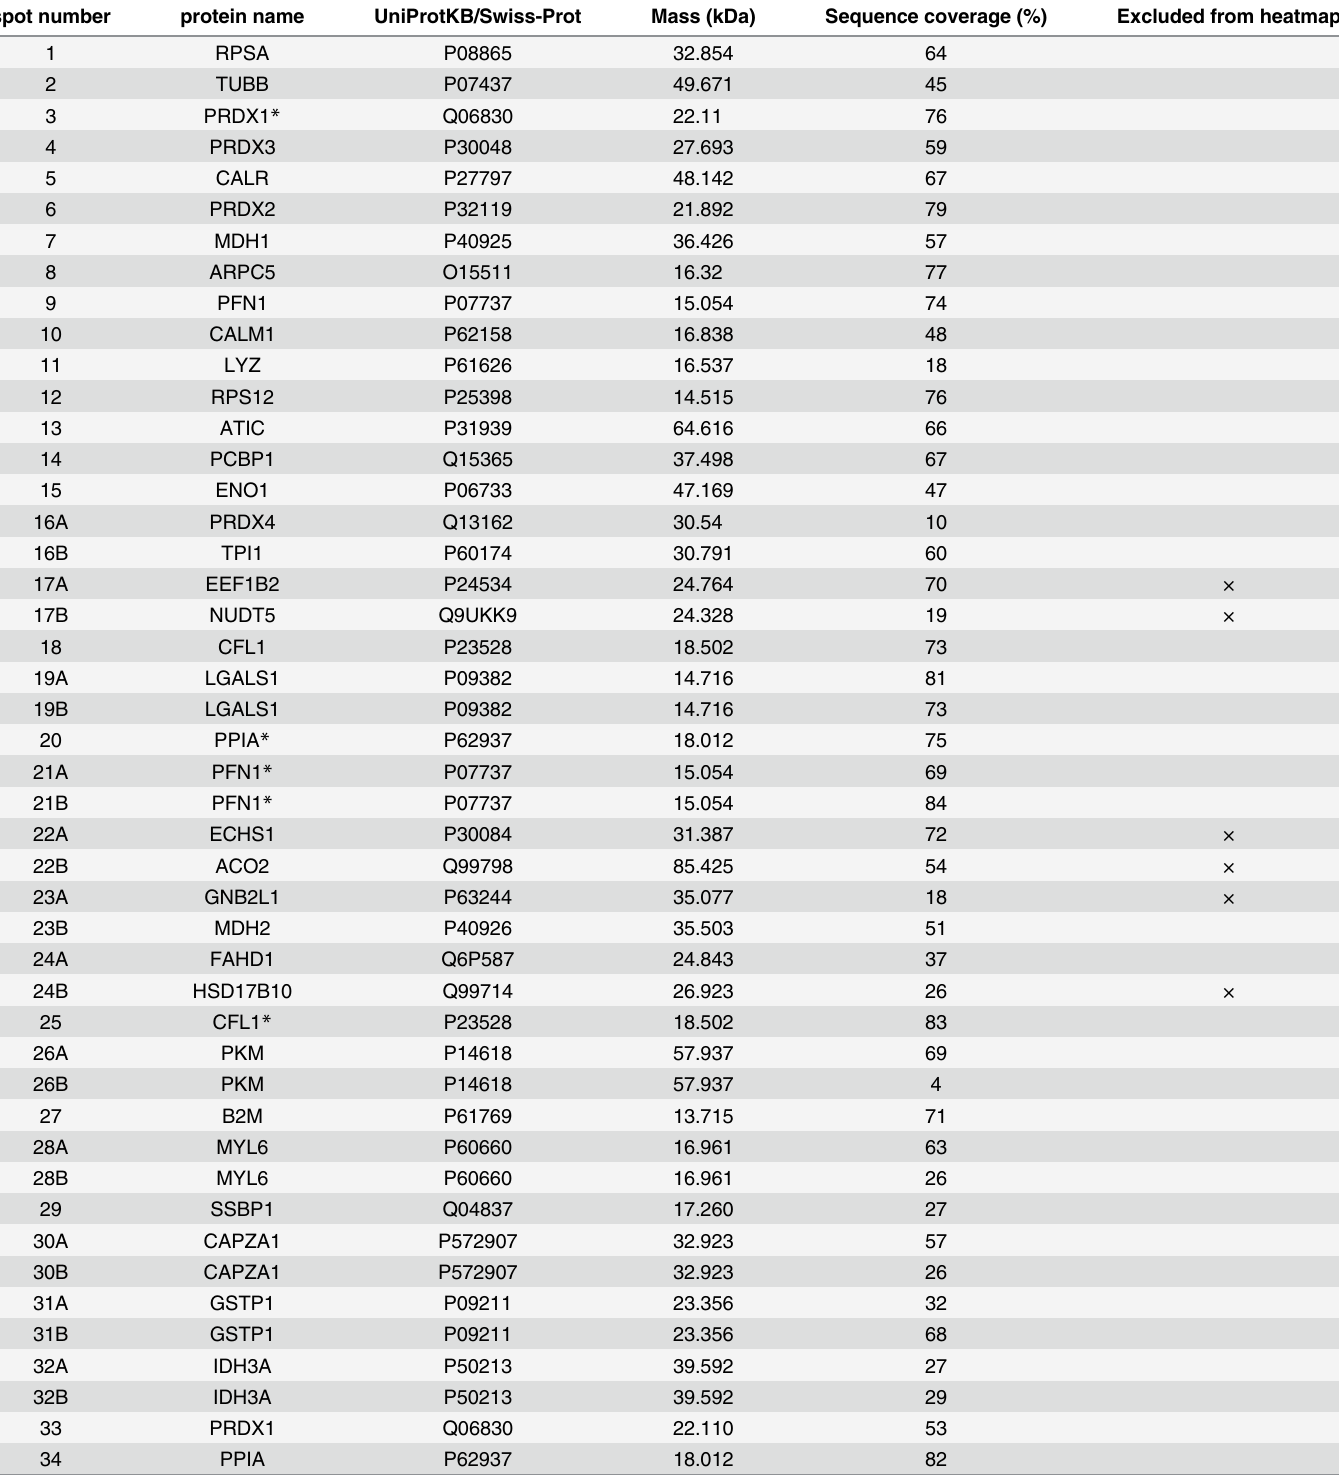
Table 1. Altered expression of proteins identified by